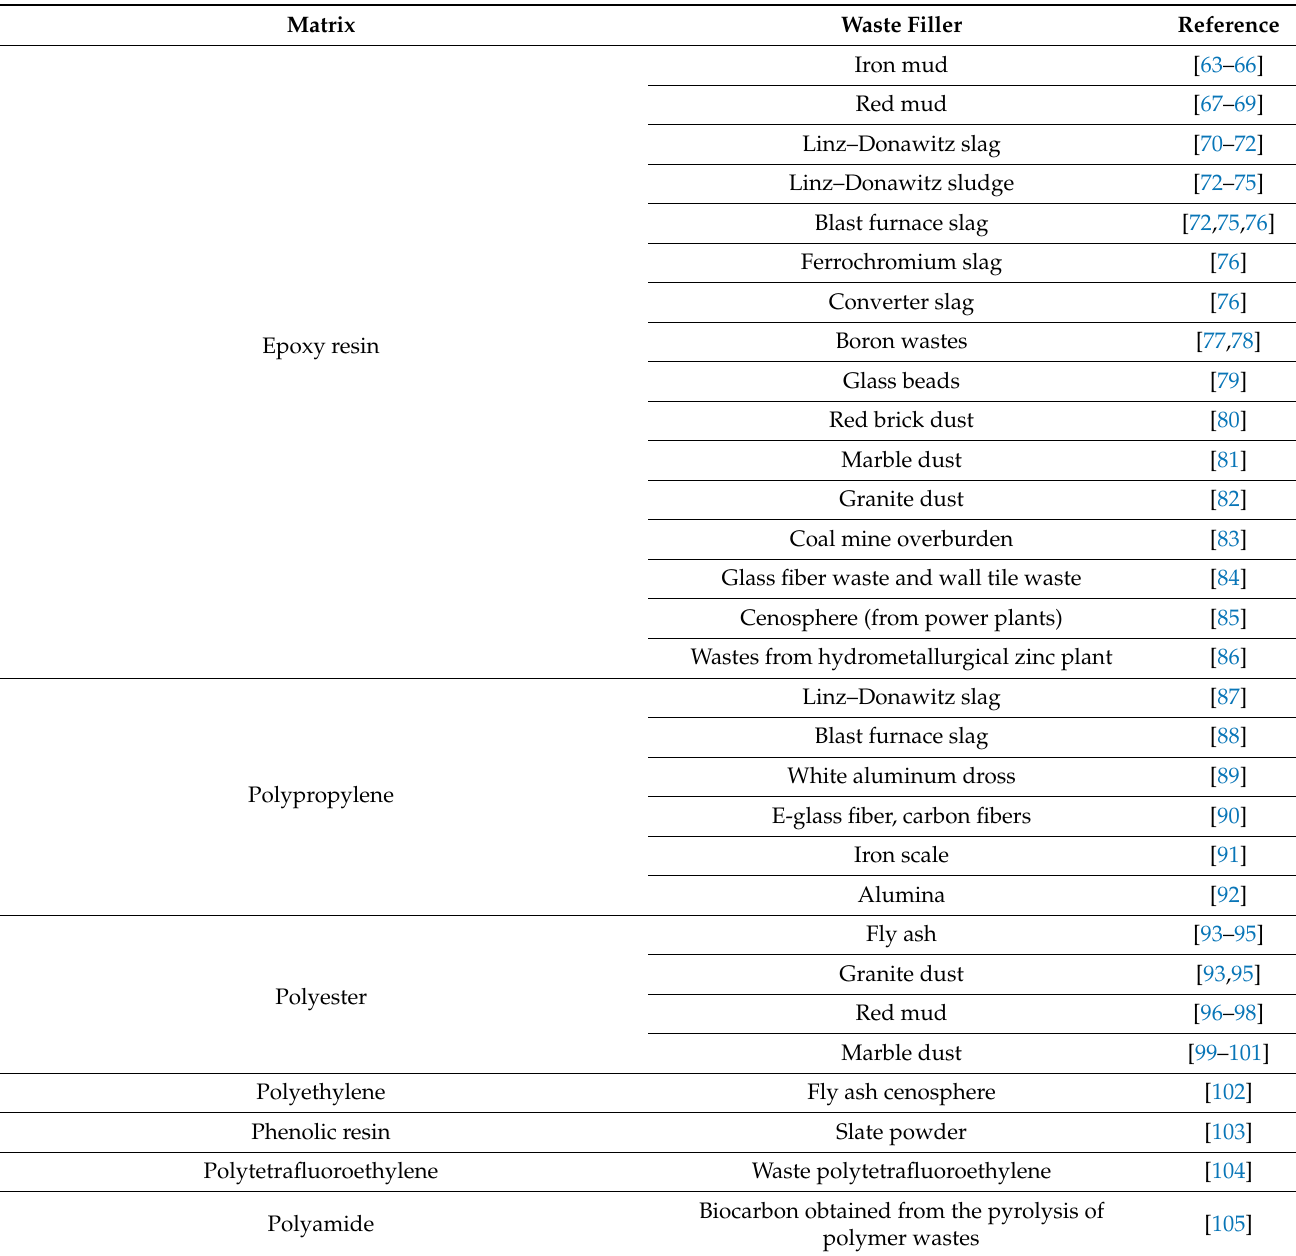
Table 2. Polymer and metal matrix composites reinforced with industrial waste materials.